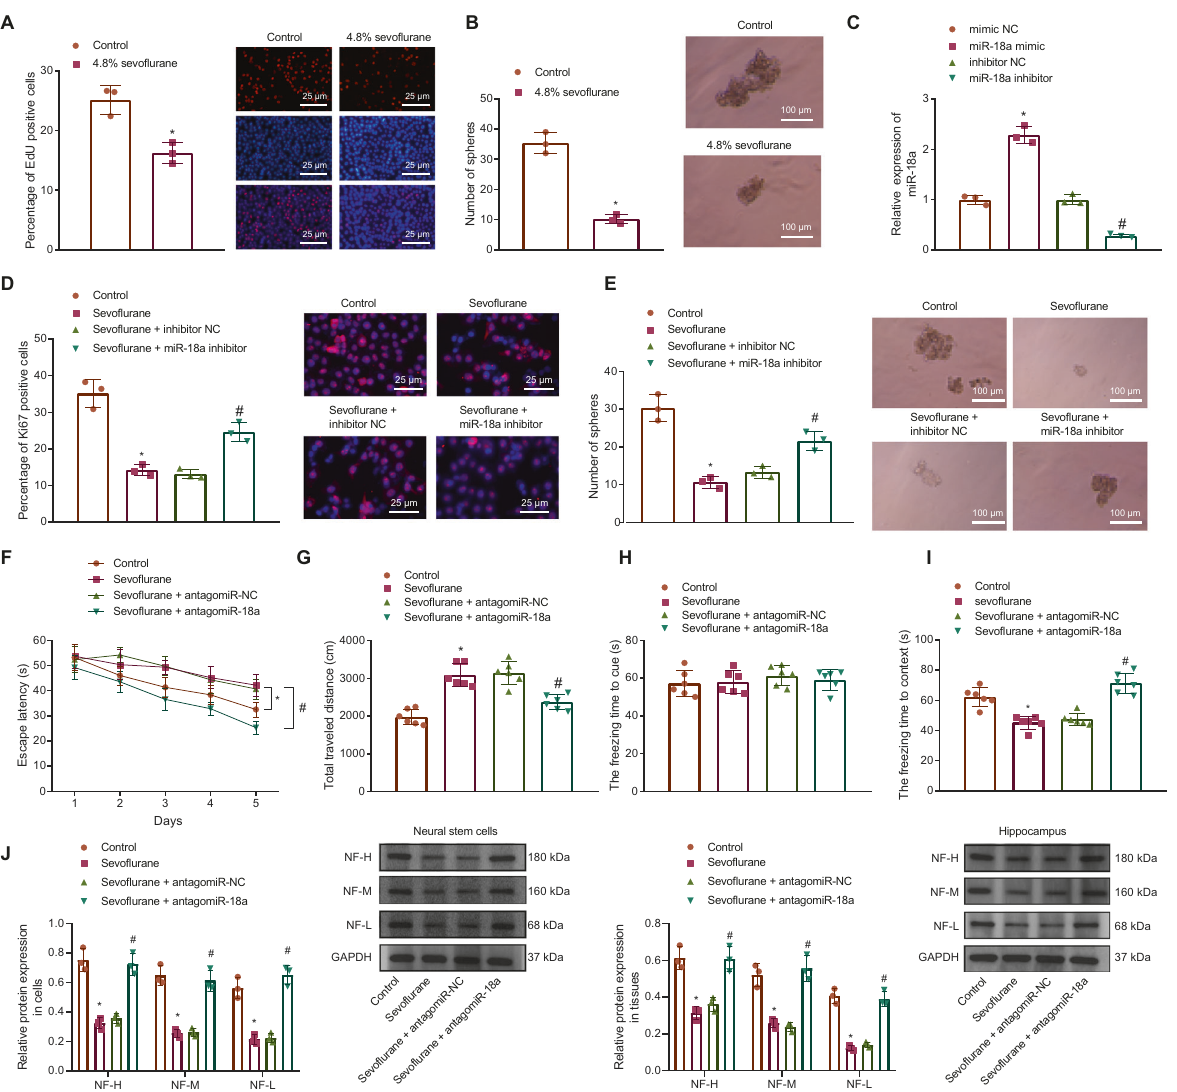
Fig. 2 Sevo fl urane induces miR-18a expression to affect NSC proliferation and neurodevelopment in rats. A The effect of 4.8% sevo fl urane on the NSC proliferation detected by EdU staining (bar = 25 μ m) (DAPI: the nucleus in blue fl uorescence, EdU staining: red fl uorescence). B The effect of 4.8% sevo fl urane on the NSC sphere-forming ability (bar = 100 μ m). C The ef fi ciency of miR-18a knockdown or overexpression detected by RT-qPCR. D The effect of miR-18a expression on the proportion of Ki67 positive cells under sevo fl urane treatment detected by immuno fl uorescence assay (bar = 25 μ m); PI: the nucleus in red fl uorescence, Ki67: green fl uorescence. E The sphere-forming ability of NSCs after treatment of sevo fl urane or miR-18a inhibitor (bar = 100 μ m). F The effect of miR-18a expression under sevo fl urane treatment on the movement time of rats in the water maze assessed by Morris water maze test; n = 6. G The effect of miR-18a expression under sevo fl urane treatment on the movement distance of rats in the open fi eld assessed by open fi eld test; n = 6. H The effect of miR-18a expression on the freezing time to cue of rats under sevo fl urane treatment assessed by conditioned fear test; n = 6. I The effect of miR-18a expression on the freezing time to context of rats under sevo fl urane treatment assessed by conditioned fear test; n = 6. J The expression of neural cell marker proteins (NF-H/NF-M/NF-L) in cells and tissues after sevo fl urane or antagomiR-18a treatment detected by Western blot analysis. * p < 0.05 vs. the control/mimic NC group, # p < 0.05 vs. the inhibitor NC/sevo fl urane + inhibitor NC/sevo fl urane + antagomiR-NC group. Data were measurement data, expressed as mean ± standard deviation, and analyzed using independent sample t -test. The cell experiment was repeated 3 times